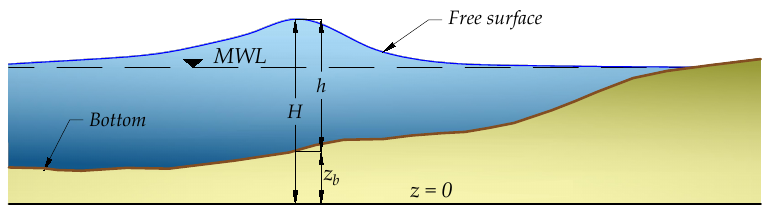
Figure 3. Definition scheme of the adopted